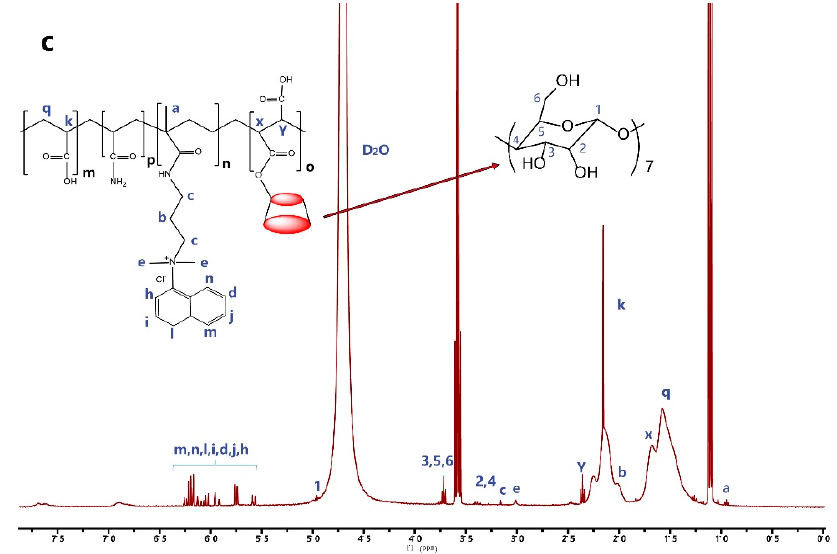
Figure 2. 1 H NMR spectrum: ( a ) MAH- β -CD, DMSO; ( b ) NAP, D 2 O; ( c ) HGP,D 2 O.